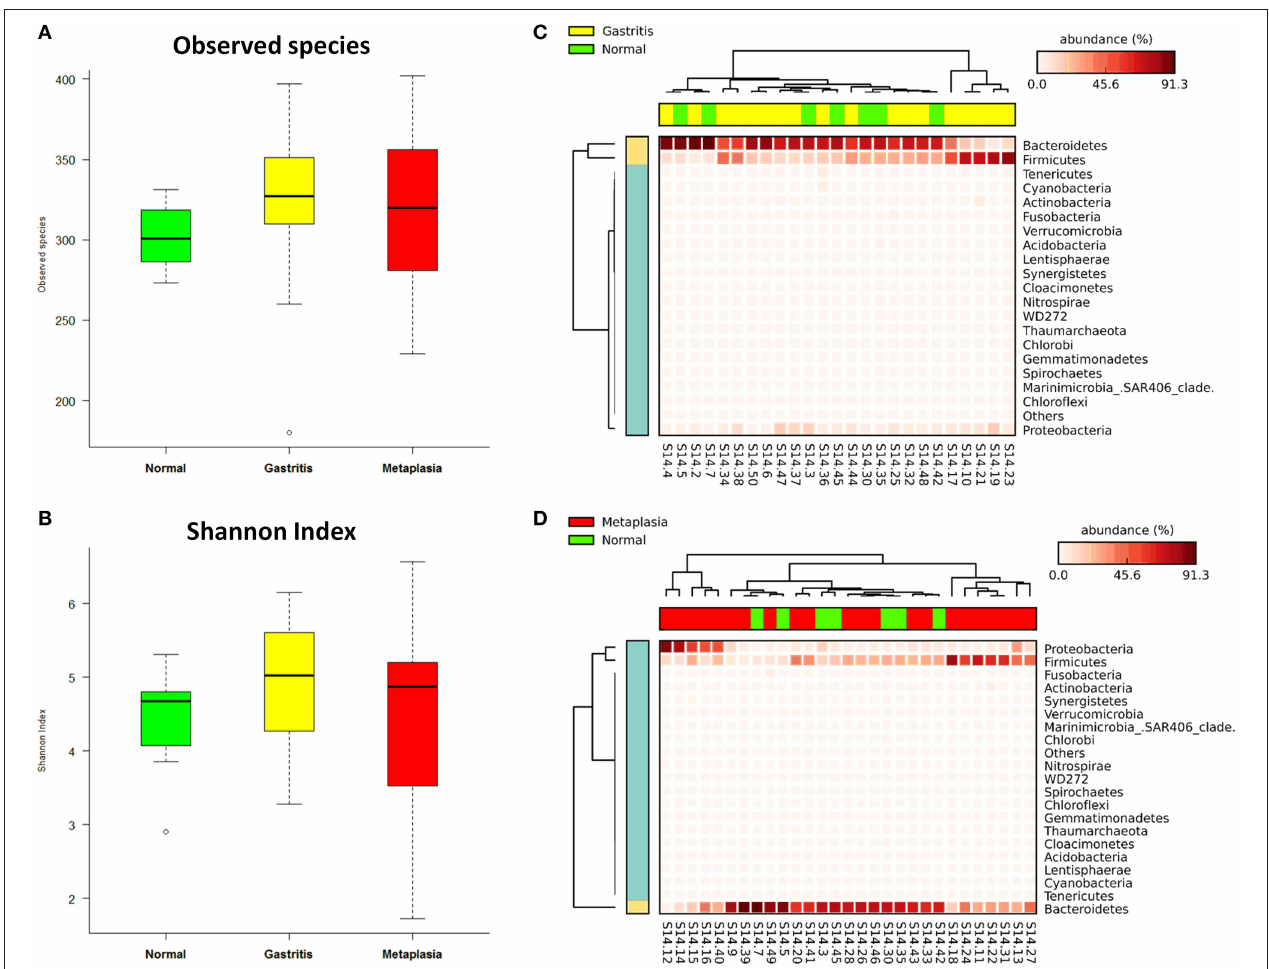
FIGURE 3 | Associations of gastric lesions with fecal microbiota. (A) Boxplot of observed species in different gastric lesion groups. (B) Boxplot of Shannon index in different gastric lesion groups. (C) Heat-map demonstrating the relative abundance of different phyla in gastritis ( n = 18) and normal ( n = 7) samples. (D) Heat-map showing the relative abundance distributions of different phyla in metaplasia ( n = 22) and normal